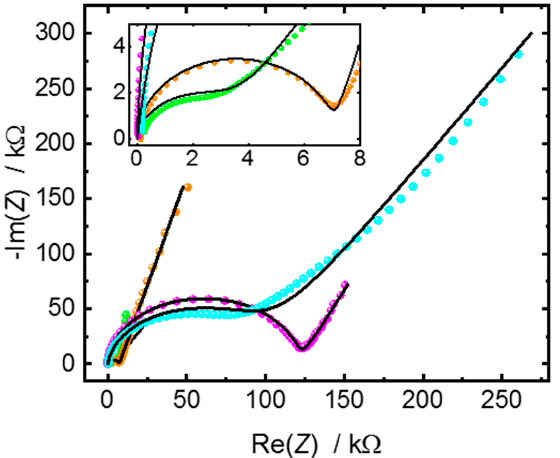
Figure A1. Nyquist plots of pure liquids of 1,2,3-triazole (cyan), 1,4-butanediol (magenta), deionized water (orange) and pure IL (green). Butanediol and water droplets were deposited on an IDE-substrates with 10 µ m gap distance and a total gap length of 1.69 m. The area of each electrode is approximately 17 mm 2 . Triazole and IL droplets were deposited on electrodes with a gap of 10 µ m gap distance and a gap length of 1 mm. The area of each electrode is 0.01 mm 2 . The frequency range is from 100 Hz (triazole), 10 Hz (butanediol), 10 Hz (water), and 1000 Hz (IL) to 5 MHz. The data are fitted with the ( R-CPE dl ) ‖ CPE geo equivalent circuit, black lines, and the parameters are given in Table A1. Table A1. The parameters determined for the impedance data in Figure A1. IL refers to [BMIM][TFSI] ionic liquid. The thickness of the double layer is assessed by λ dl = ε r ε 0 A electrode / C dl . For the permittivity ε r , the following values were used: 14 for IL [64], 40 for triazole [65], 31.9 for butanediol [66], and 80 for water.